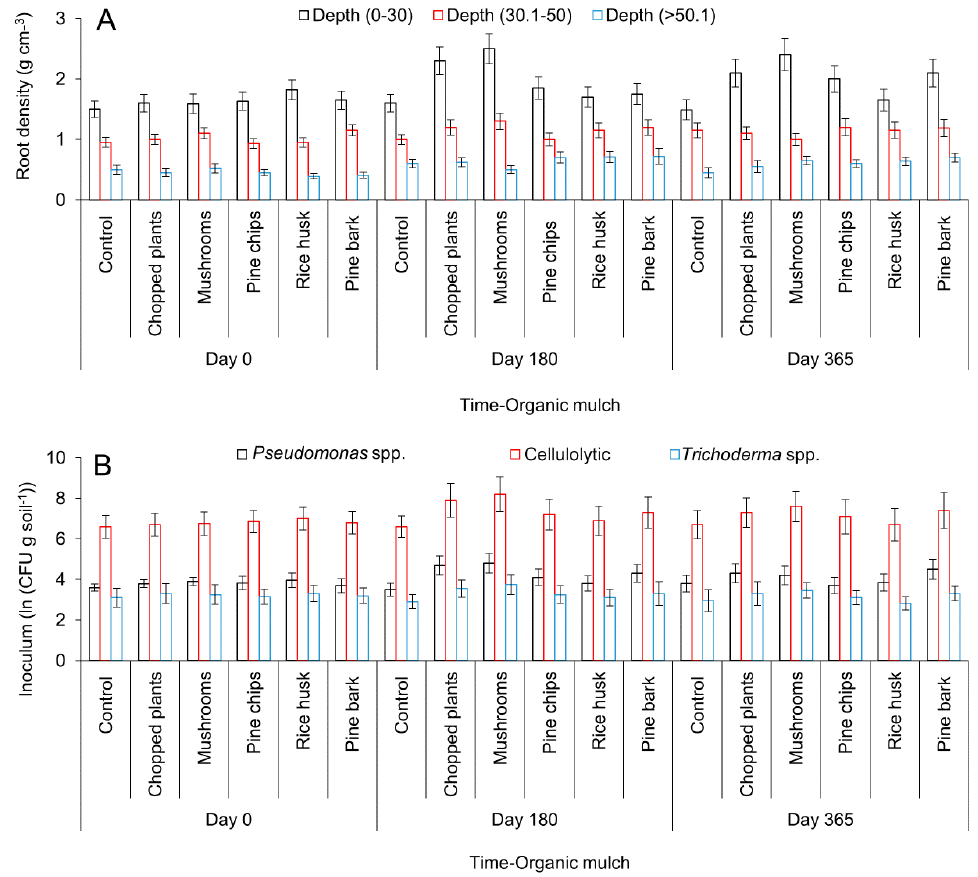
Figure 2. Root densities ( A ) and rhizosphere microorganism populations ( B ) measured after the addition of organic mulch in avocado plants. Error bars represent the confidence interval of the mean, validated by the Tukey mean separation test. No overlapping of the error bars indicates significant differences ( p > 0.05).